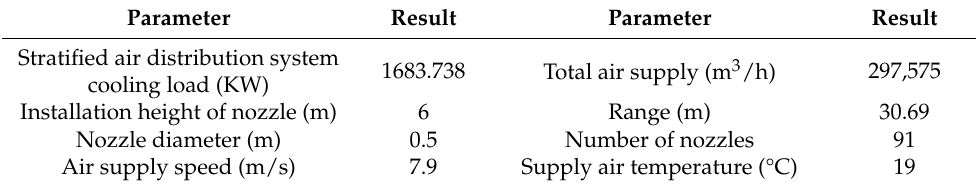
Table 2. Calculation results of air distribution in the departure